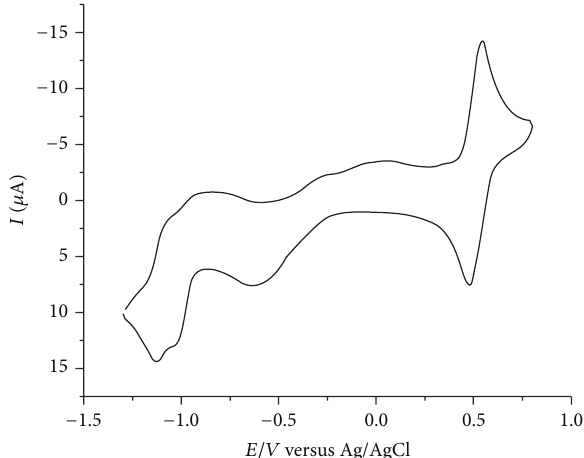
Figure 3: Cyclic voltammogram of [CoCl(dmgH) 2 (fcvpy)] recorded in acetonitrile solution of n-Bu 4 NPF 6 (0.1moldm −3 ) on a glassy carbon electrode at 100mVs −1